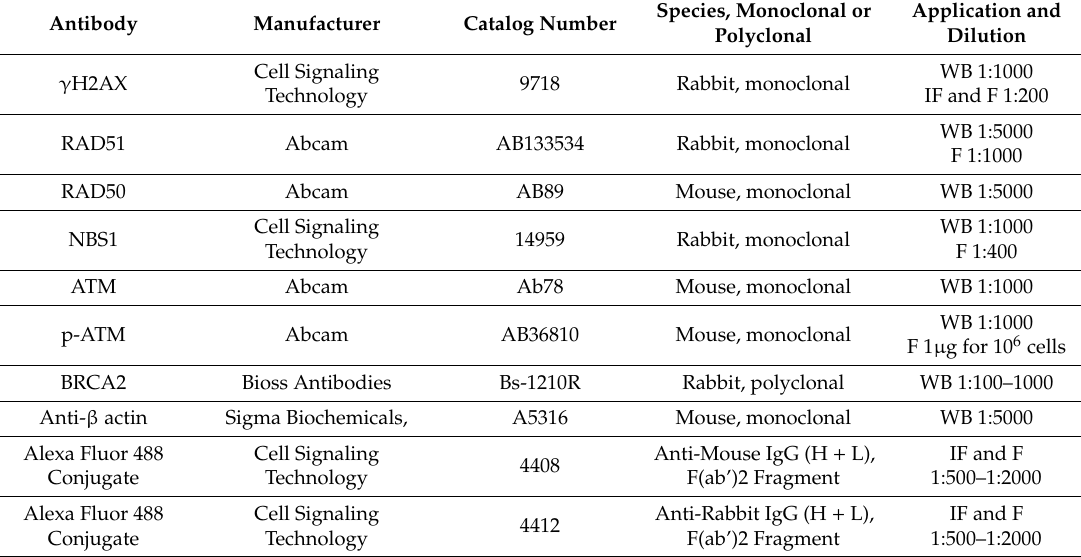
Table 1. Antibodies used in the